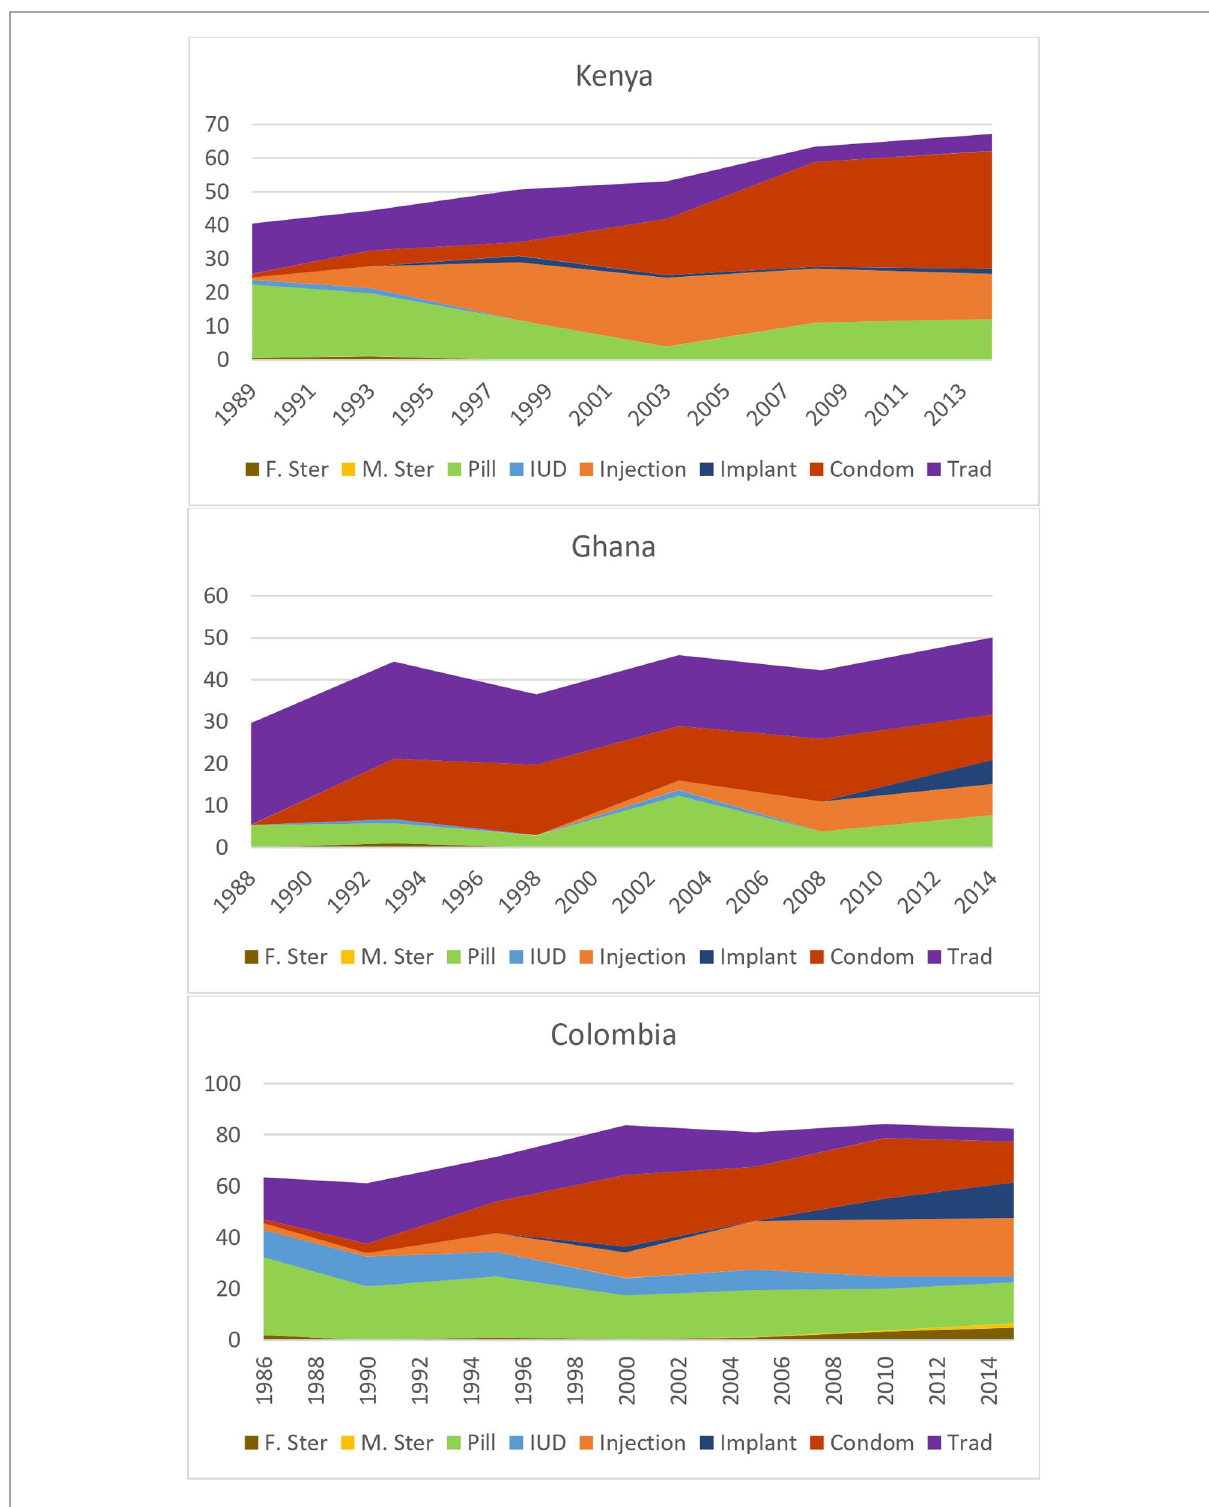
FIGURE 4 Changes over time in method Mix and contraceptive prevalence Among unmarried sexually active women aged 20 – 24 in three illustrative